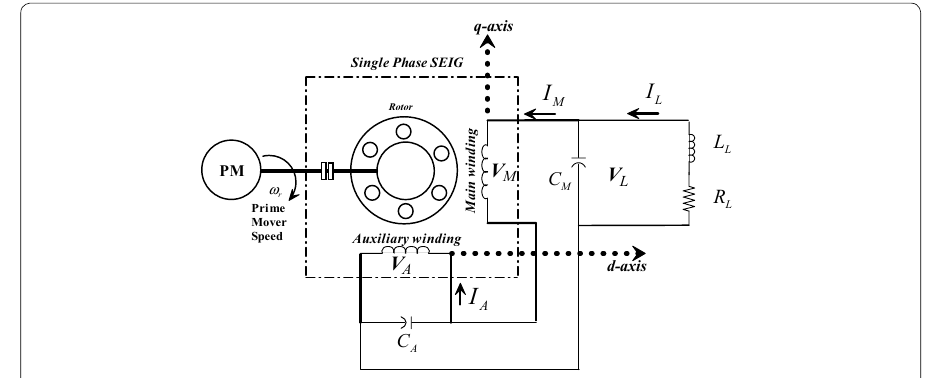
Fig. 1 The configuration of the proposed connection of